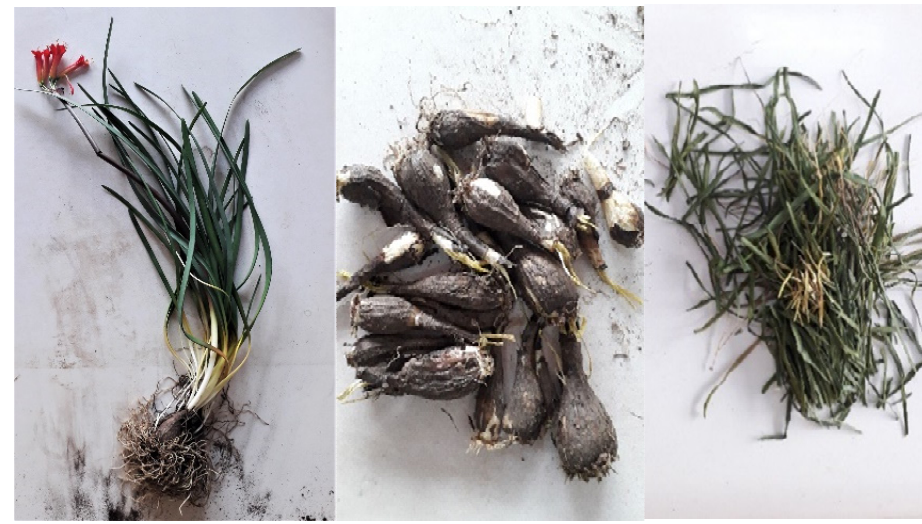
Figure 2. Phycella cyrtanthoides : entire plant ( left ), bulbs ( middle ), and leaves ( right ).